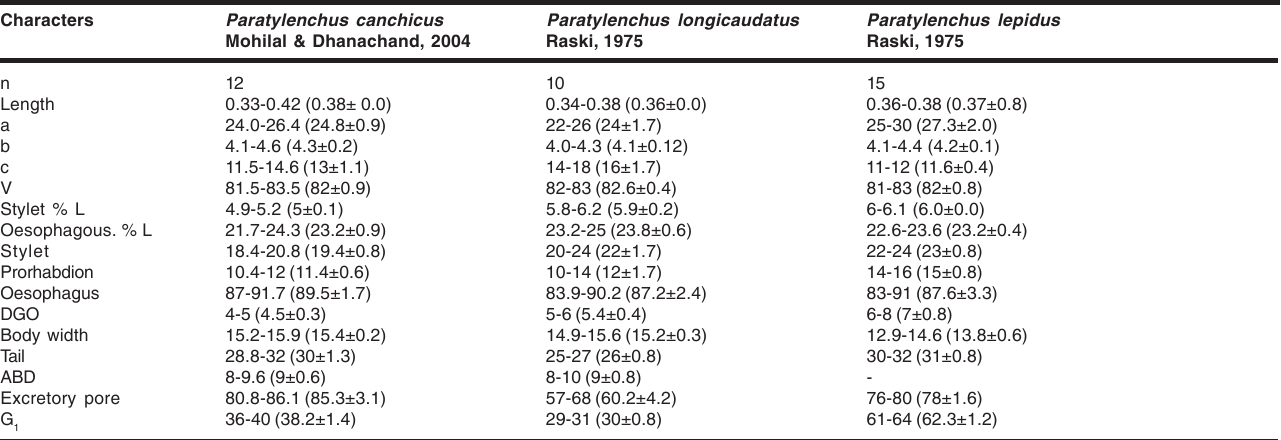
Table 1. Measurements of three females of Paratylenchus spp. All measurements in μ m, except L in mm. Characters